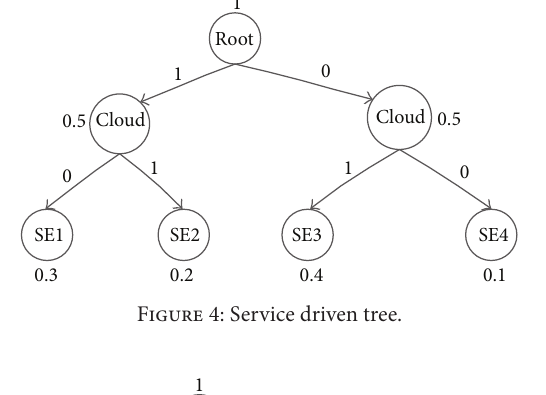
Table 1: Service driven.